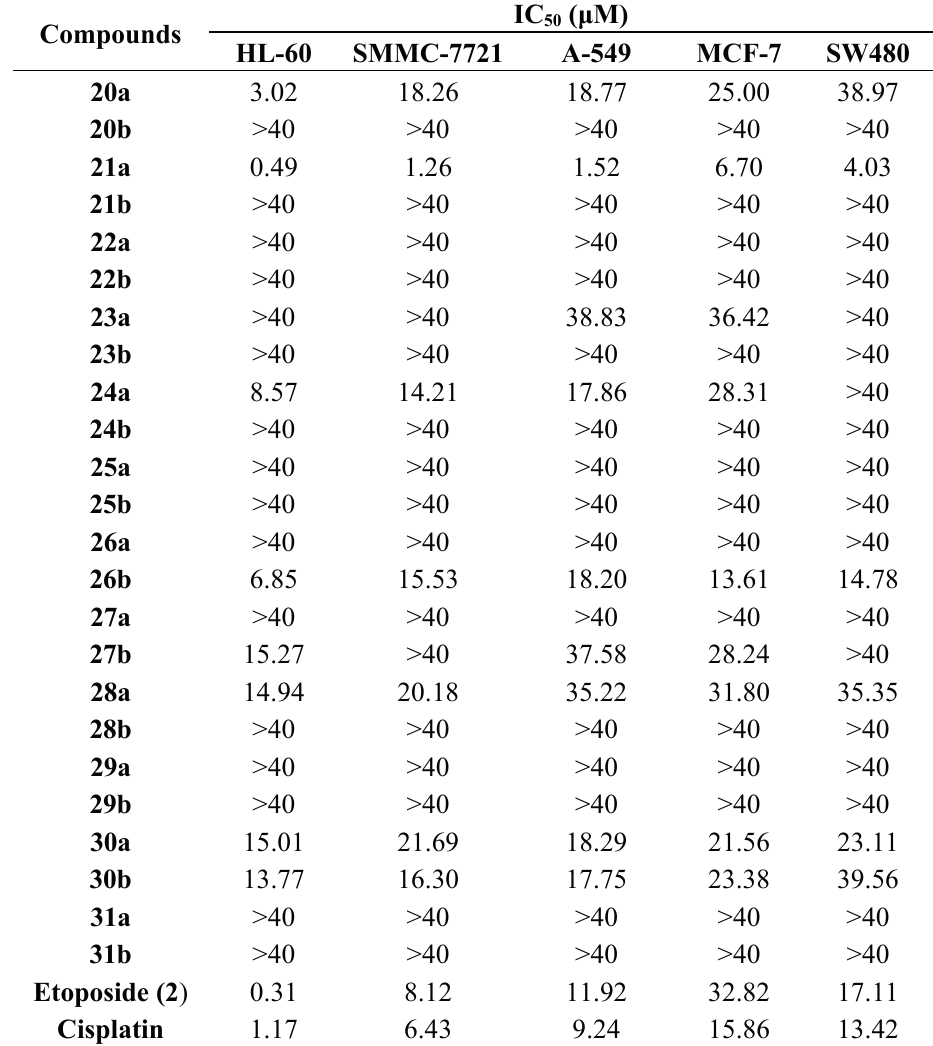
Table 2. In vitro anticancer activity (IC 50 , μ M) of compounds 20a/b – 31a/b